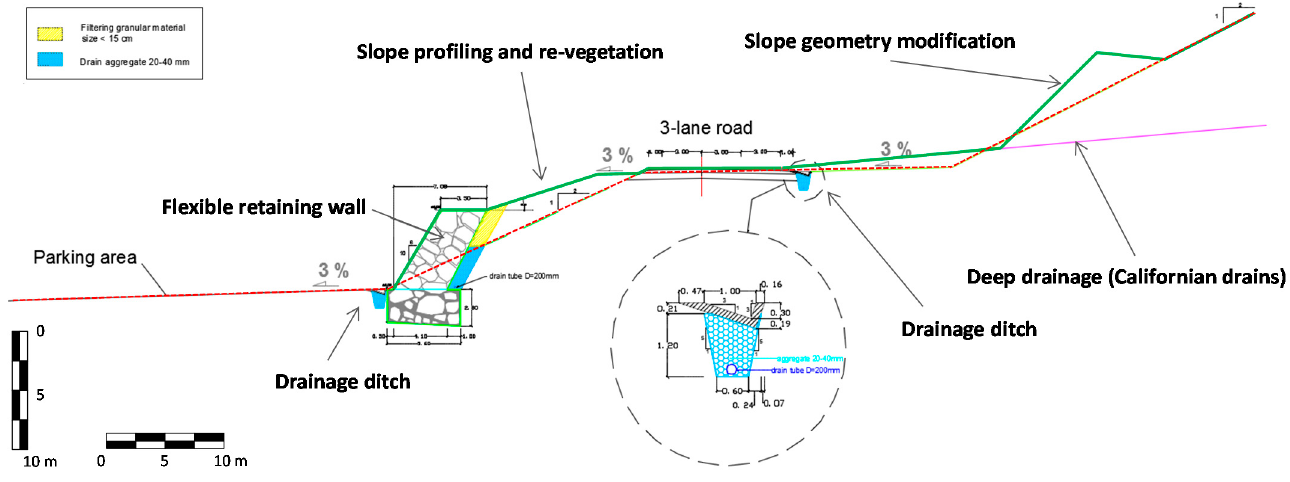
Figure 3. Stabilization measures projected; red dotted line and green line show the slope profile before and after implementing the stabilization measures (highlighted in bold), respectively.